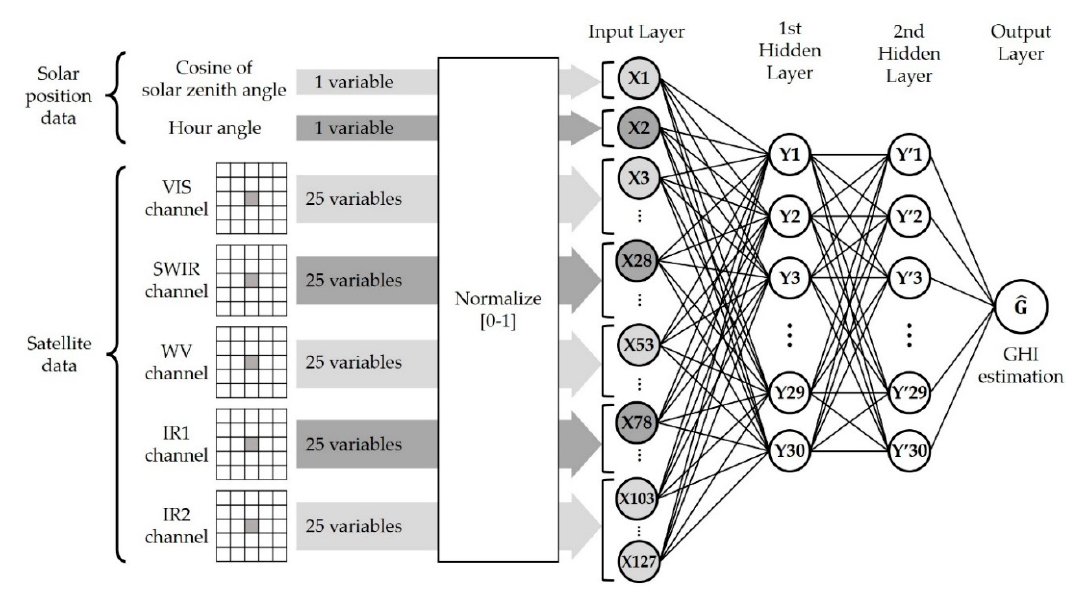
Figure 6. Final structure of the ANN model.